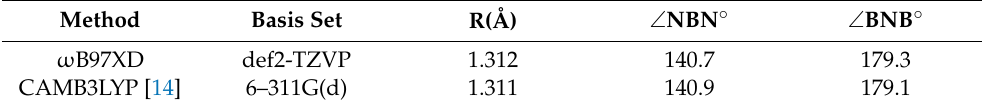
Table 1. Structural changes of B 9 N 9 under different computational conditions.